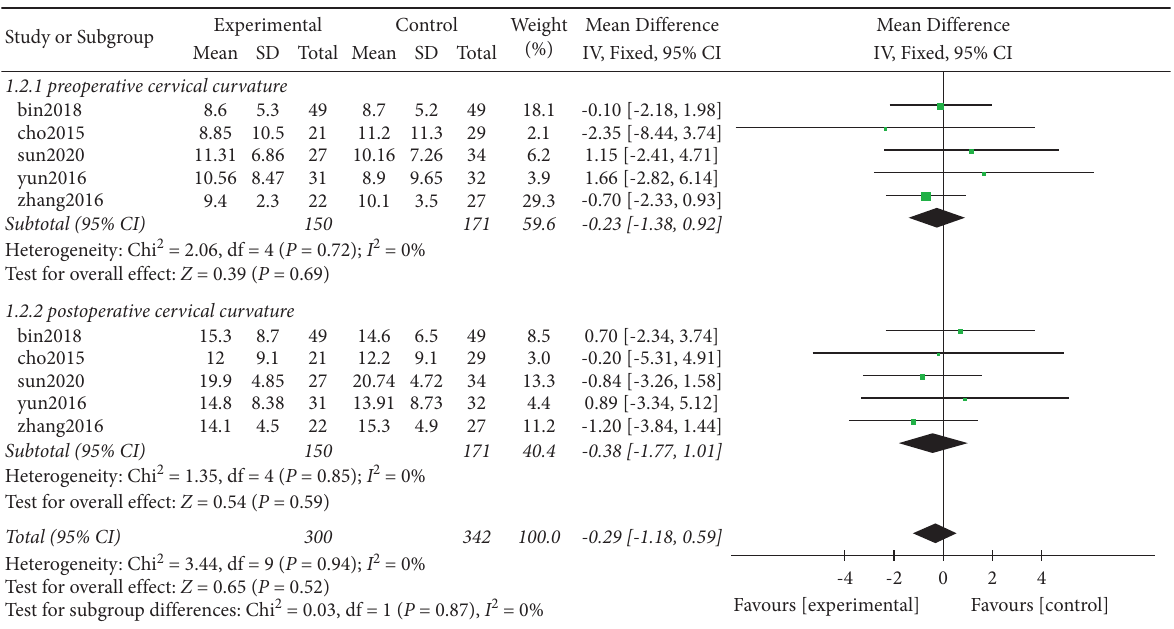
Figure 4: Cervical curvature before and after